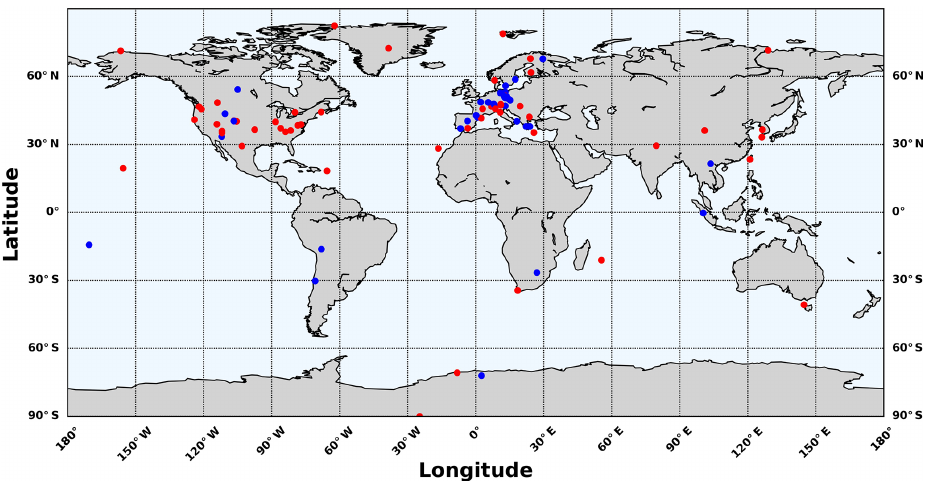
Figure 1. Location of sites contributing to the present study. In blue, sites which provided information for the reference year 2017 and in red, sites that in addition, provided > 10-year time series for optical properties used in Collaud Coen et al.